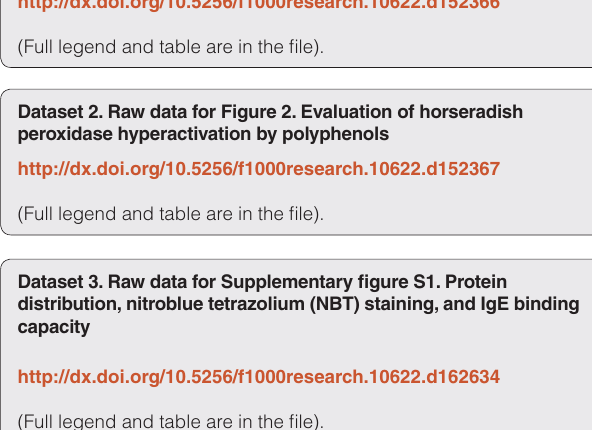
Dataset 1: Raw data for Figure 1. Protein distribution visualized by Coomassie Brilliant Blue staining (CBB), nitroblue tetrazo- lium (NBT) staining, and IgE binding capacity. (Full legend and table are in the file).